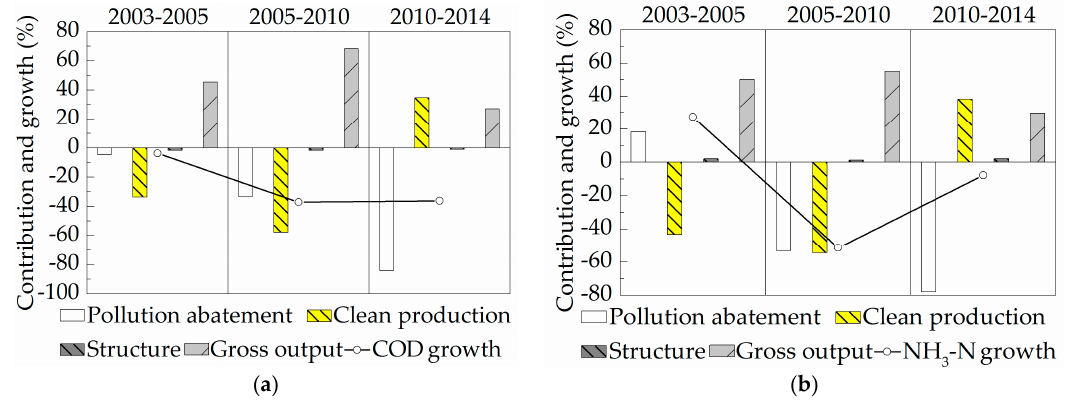
Figure 4. The growth in the discharge of the two pollutants and the contributions of their corresponding decomposition factors at three stages (2003–2005, 2005–2010 and 2010–2014). ( a ) COD and ( b ) NH 3